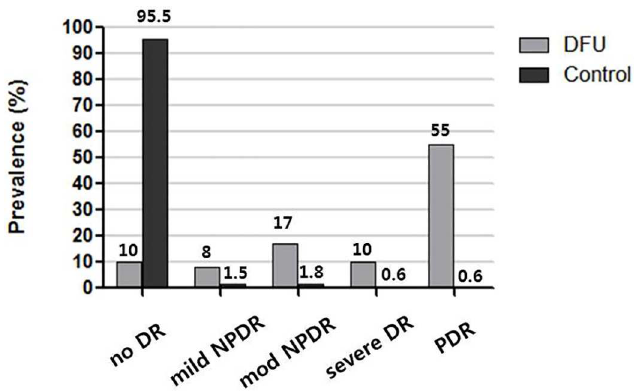
Fig 1. Prevalence of diabetic retinopathy (DR) in patients with a diabetic foot ulcer (DFU) and in control diabetic patients without a DFU. Among patients with a DFU, 90 (90%) had DR and 55 (55%) had proliferativeDR (PDR). However, only 16 (0.6%) of 2496 control group patients without a DFU had